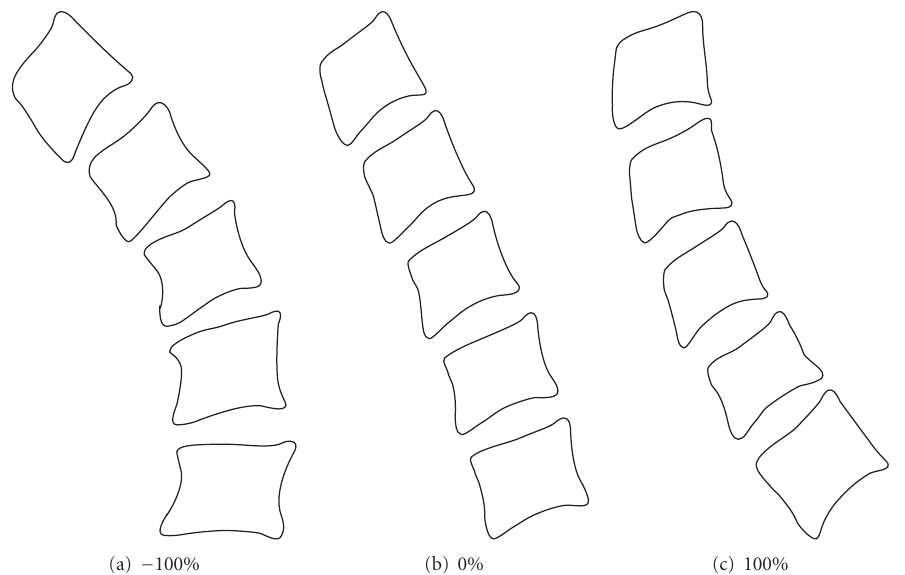
Figure 14: E ff ects of variations along the principal directions of a column mode.